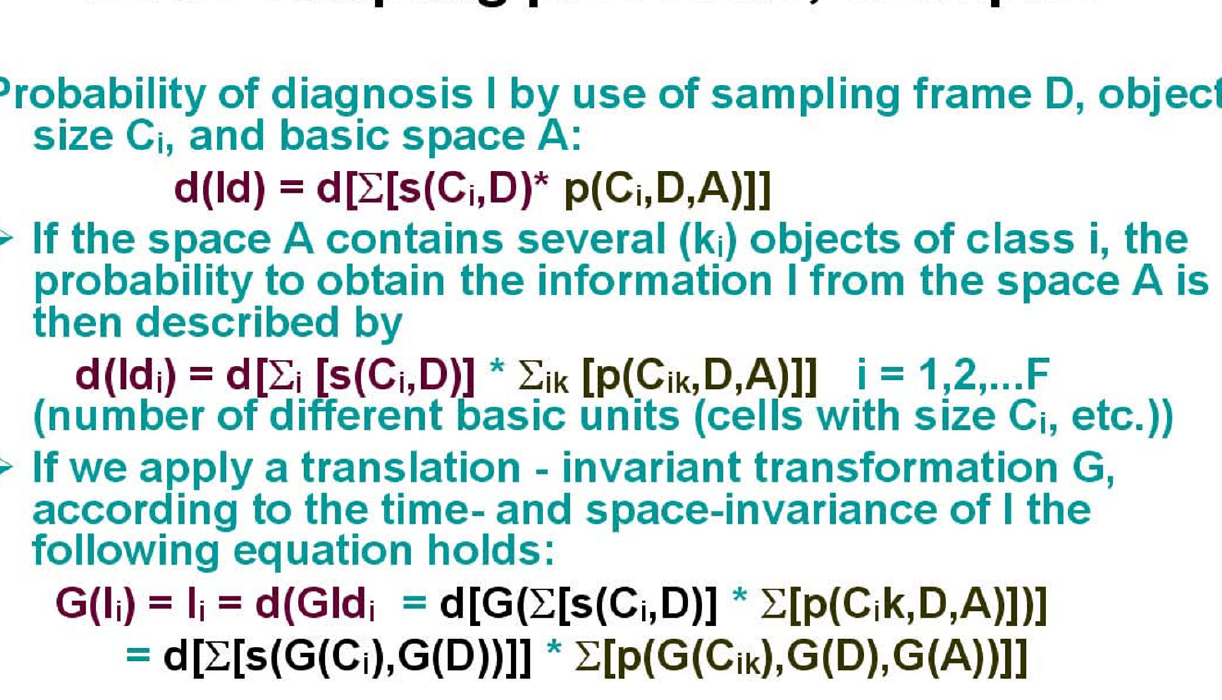
Figure 3 Examples of probability calculations in various sampling procedures